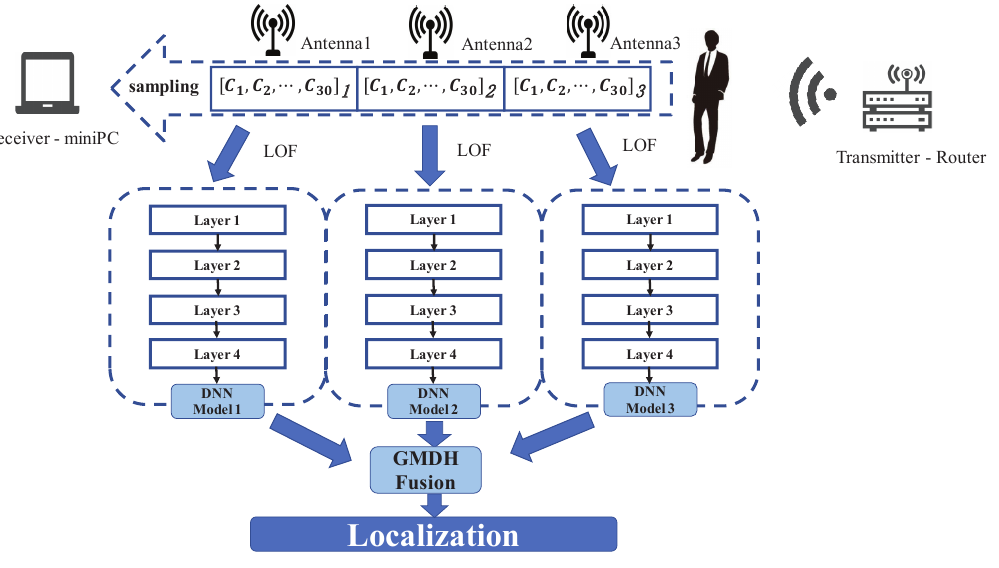
Figure 2. ModelF